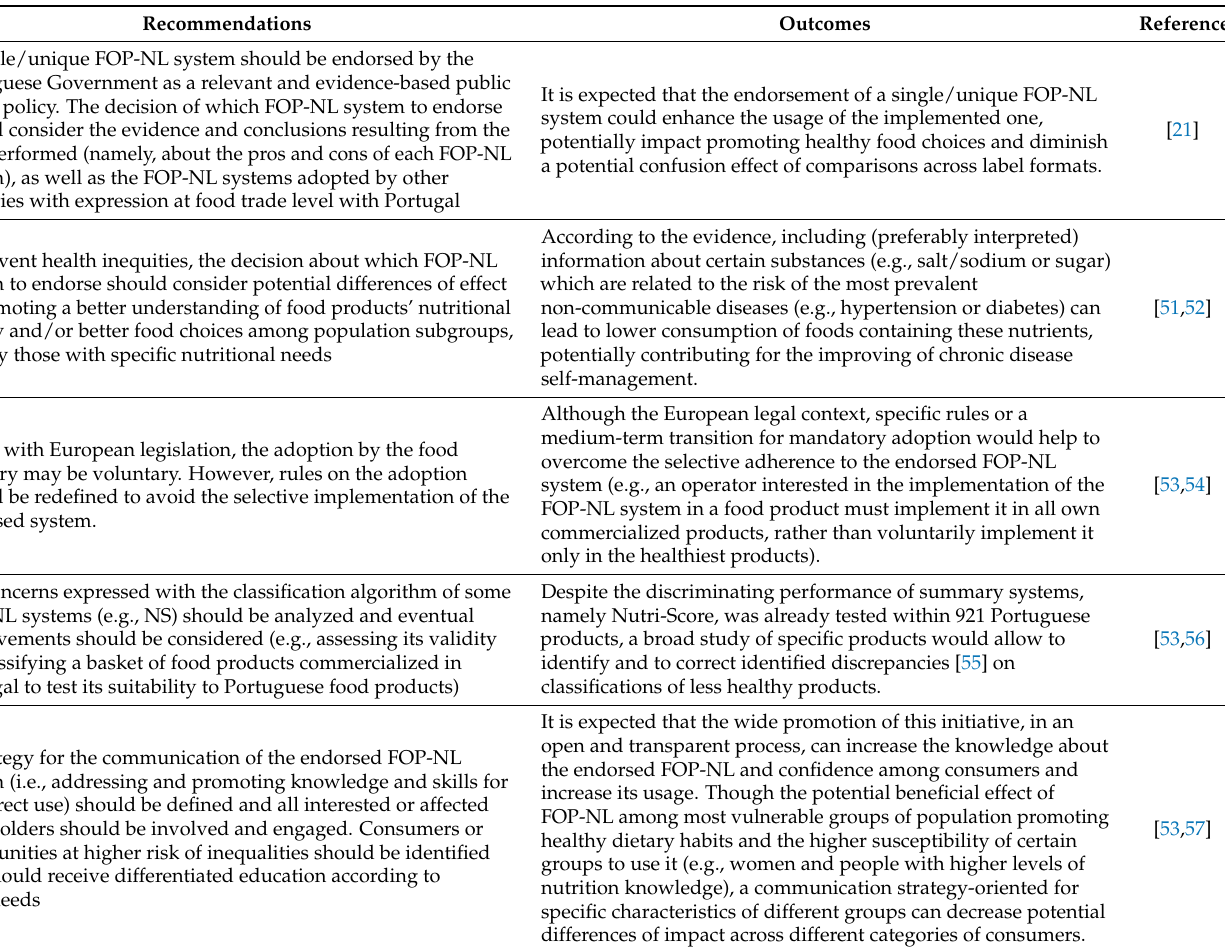
Table 3. Recommendations (and supporting evidence) for the process of implementation of the